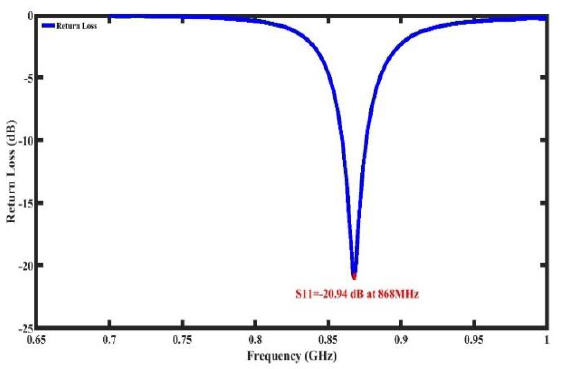
Fig.4. Return loss Vs Frequency /GHz of proposed RFID antenna.